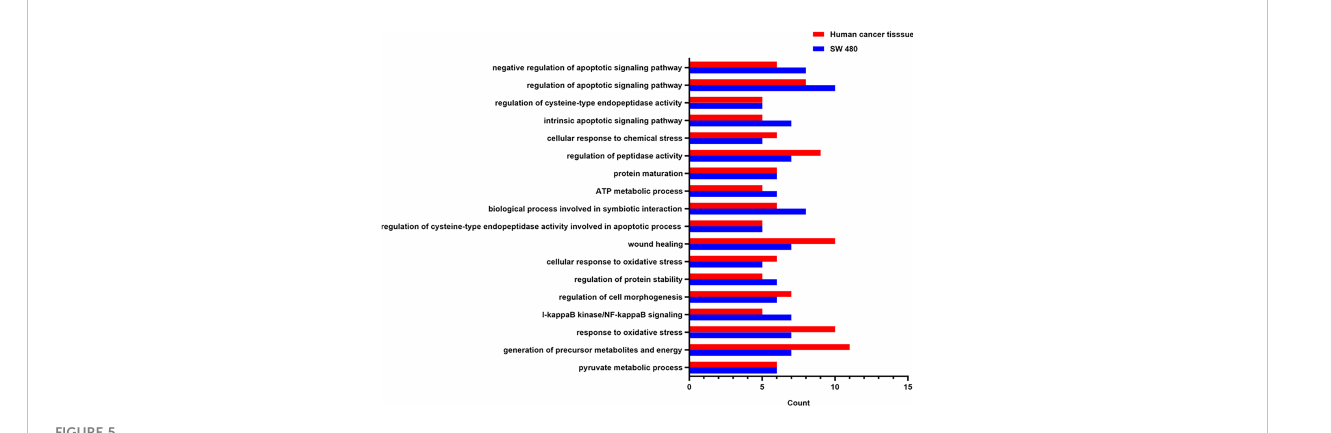
FIGURE 5 The top 12 most signi fi cant biological processes involved by SNO proteins.